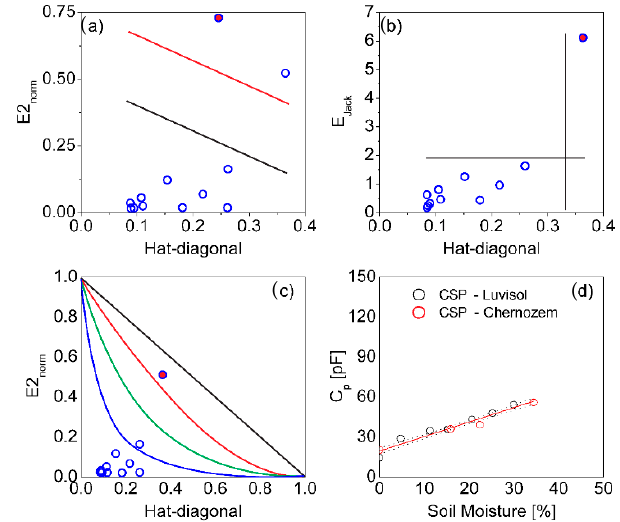
Figure 8. The residual analysis for CSP sensor element presented by ( a ) Pregibon, ( b ) William, and ( c ) the L-R plot, ( d ) regression plot after data filtering for CSP sensor and dataset Luvisol + Chernozem. Valid mathematical models for all realized sensors were estimated by linear regression analysis.